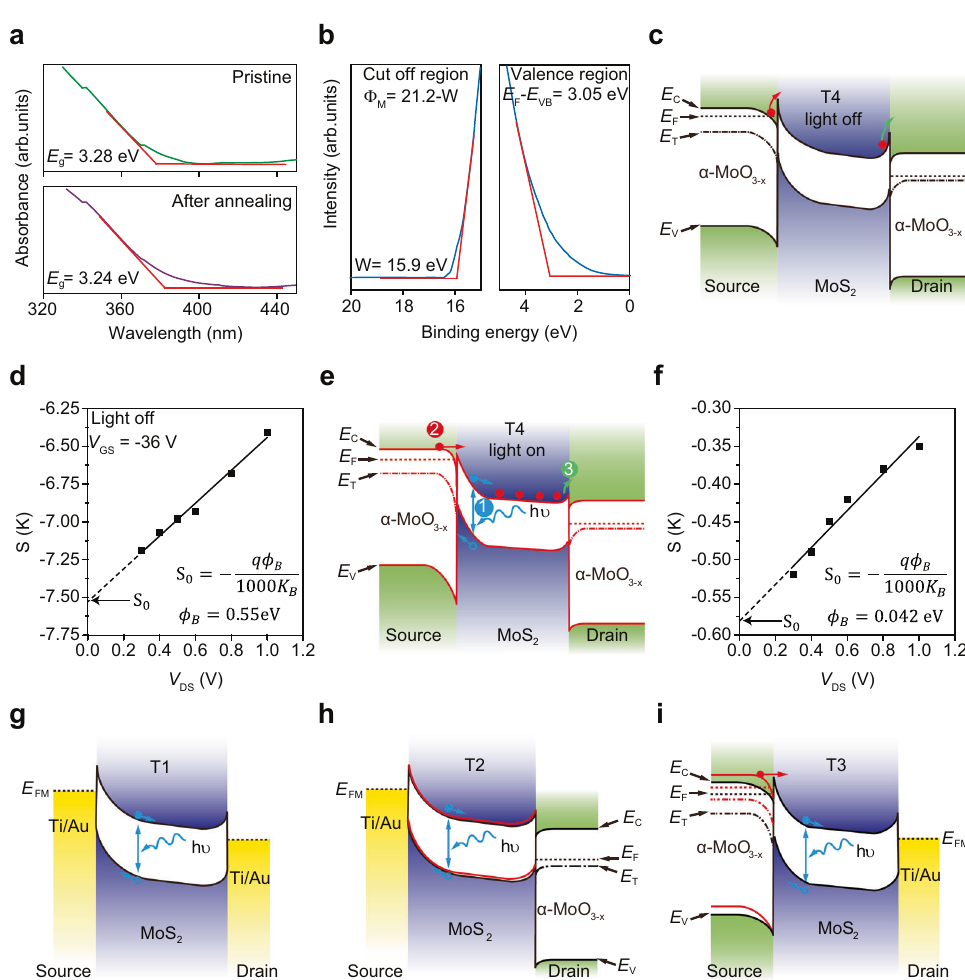
Fig. 4 Double-heterojunction photo-induced barrier-lowering mechanism. a Absorbance spectrum of the pure and annealed α -MoO 3-x fl akes. E g is the bandgap. The red line is an auxiliary line for extracting E g . b Ultraviolet photoelectron spectroscopy (UPS) measurement of α -MoO 3-x fl akes. A He-I UV light source ( h ν = 21.2 eV) was used to obtain the UPS spectra. The binding energy is referred to the Fermi level. The work function ( Φ M ) was obtained from the cutoff region, which is 5.32 eV. The difference between the Fermi level and the valence band maximum was calculated to be 3.05 eV from the valence region. The red lines are auxiliary lines. c Energy band diagram at the light-off state. E C is the conduction band minimum, E F is the Femi level, E T is the defect band and E V is the valence band maximum. The red circle represents electrons. The red arrow represents the electron inject from source electrode to channel and green arrow represents the electron inject from channel to drain electrode. d Slopes extracted from Supplementary Fig. 18m as a function of V DS . ϕ is the Schottky barrier about 0.55 eV, derived from the y -intercept, S 0 . e Energy band diagram at the light-on state to illustrate the B photo-induced barrier-lowering mechanism. The blue symbol (1) represents the photo-generation of electron-hole pairs, the red symbol (2) the holes and electrons separating process to reduce barrier and increase electrons injection, and the green symbol (3) the injection electrons reducing the barrier at drain side. The hv represents incident photon. f Slopes extracted from Supplementary Fig. 18n as a function of V DS . ϕ is about 0.042 eV, derived from the B y -intercept, S E 0 . g Energy band diagram of device T1. When there is incident light, the photo response mainly comes from the MoS 2 material itself. FM is the Femi level of Ti. h Energy band diagram of device T2. When there is incident light, there is a slightly better photo response mainly due to barrier-lowering at the Drain α -MoO 3-x . E FM is the Femi level of Ti. i Energy band diagram of device T3. When there is incident light, a large photo gain was achieved because Source barrier-lowering enhanced electron injection. E FM is the Femi level of